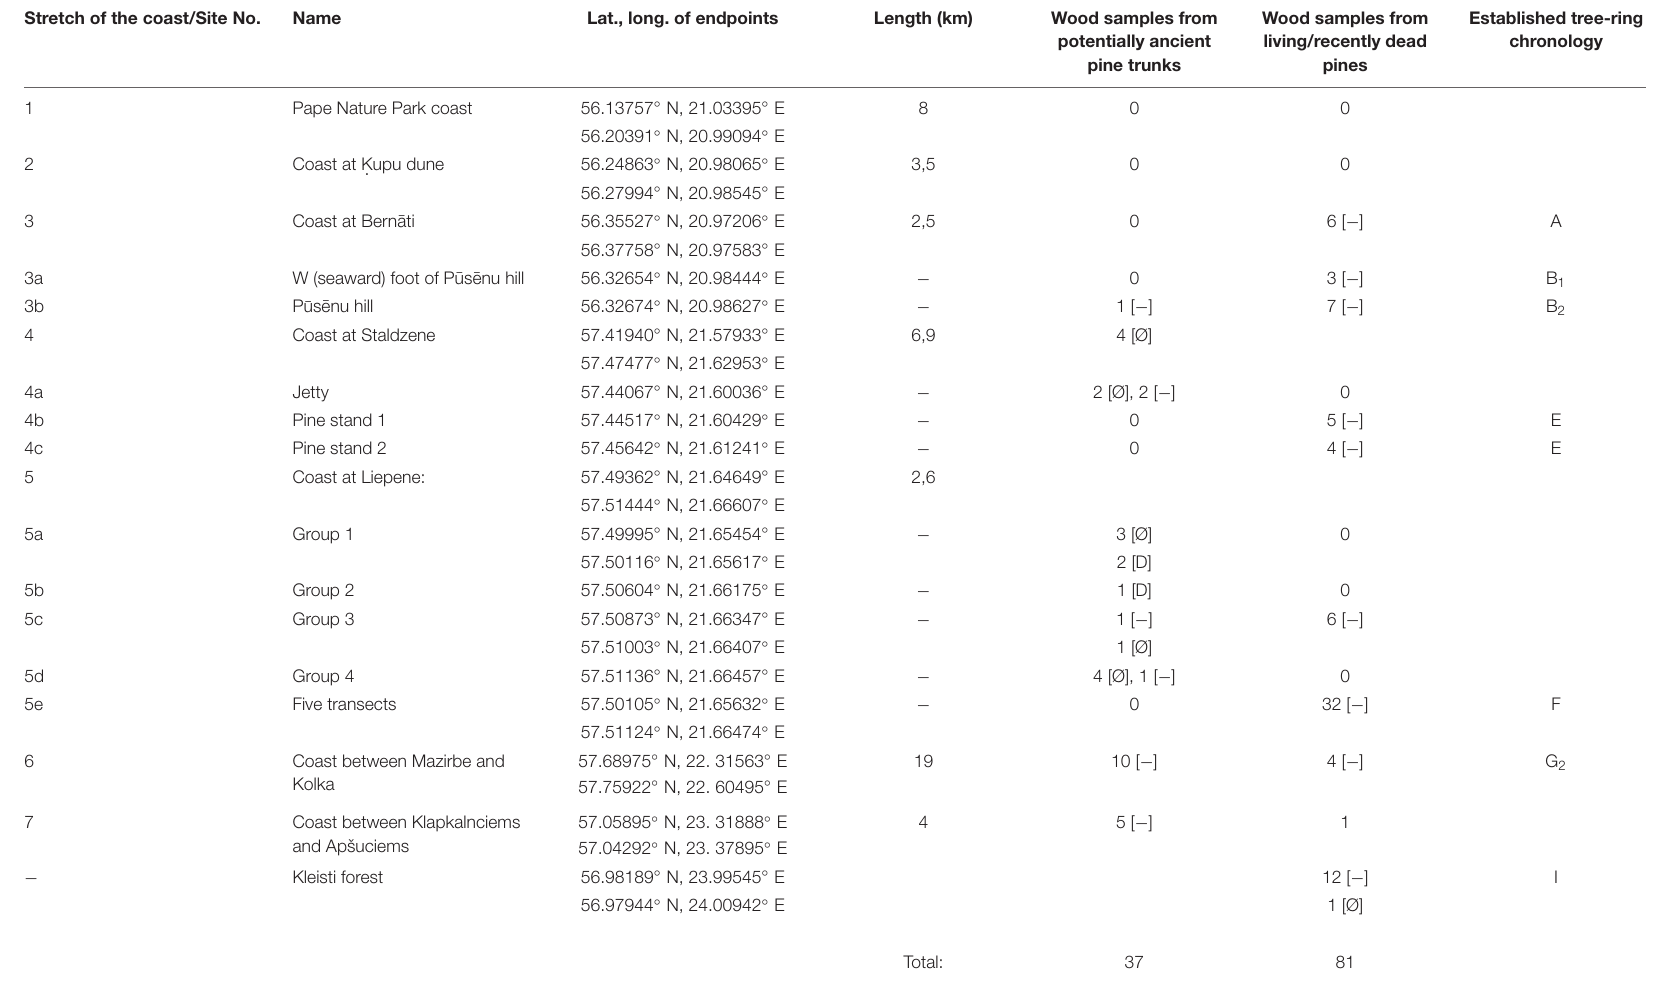
TABLE 1 | Stretches of the coast of western Latvia where remains of ancient tree trunks were surveyed, giving the numbers of wood samples taken ( Ø , sawn trunk cross-section; D , sawn sample extending to center of trunk; − , core sample). Stretch of the coast/Site